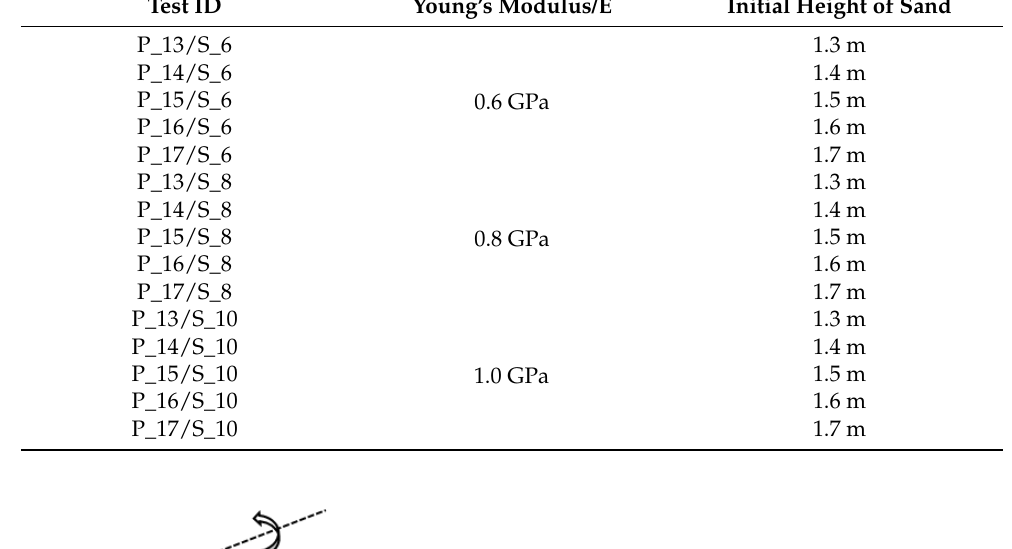
Table 2. Numerical simulation program.